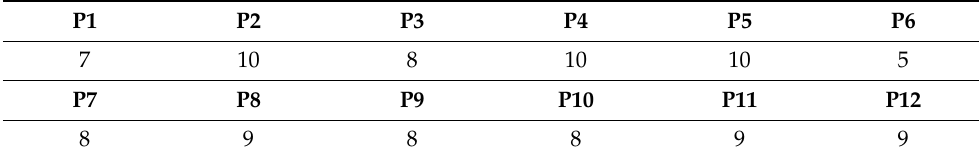
Table 3. The results of the immersion